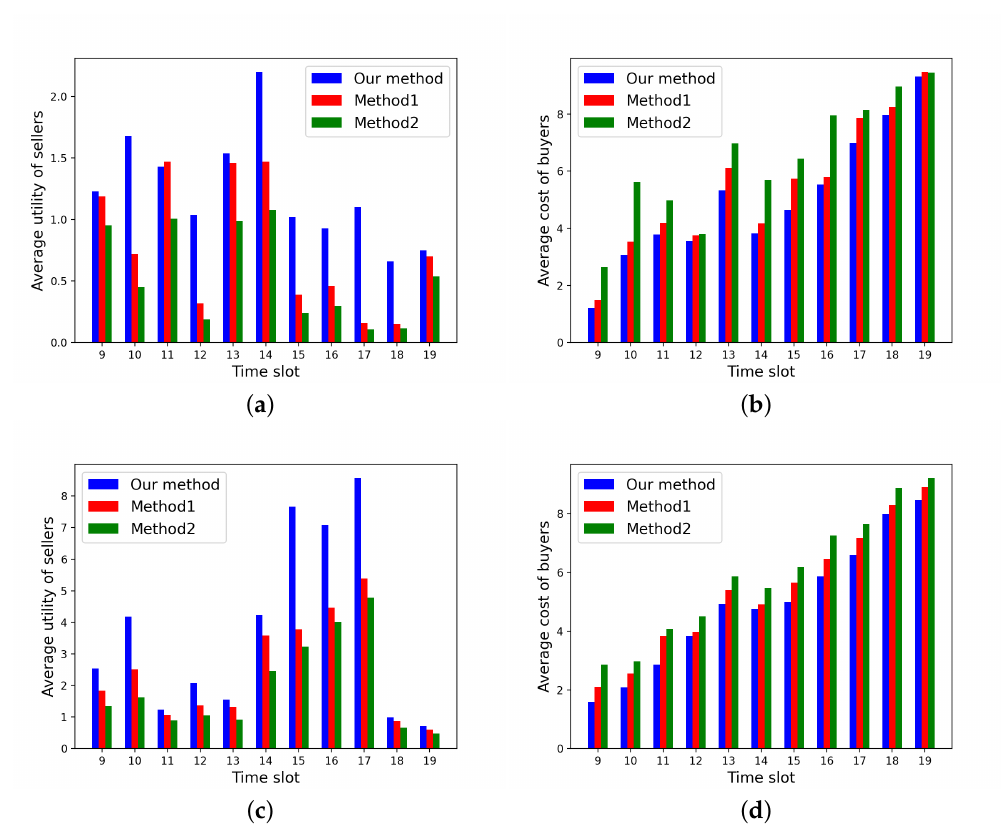
Figure 2. ( a ): Average utility of sellers, ( b ): Average cost of buyers, of Building A, ( c ): Average utility of sellers, ( d ): Average cost of buyers, of Building B using Methods 1 and 2, and our method throughout the day.